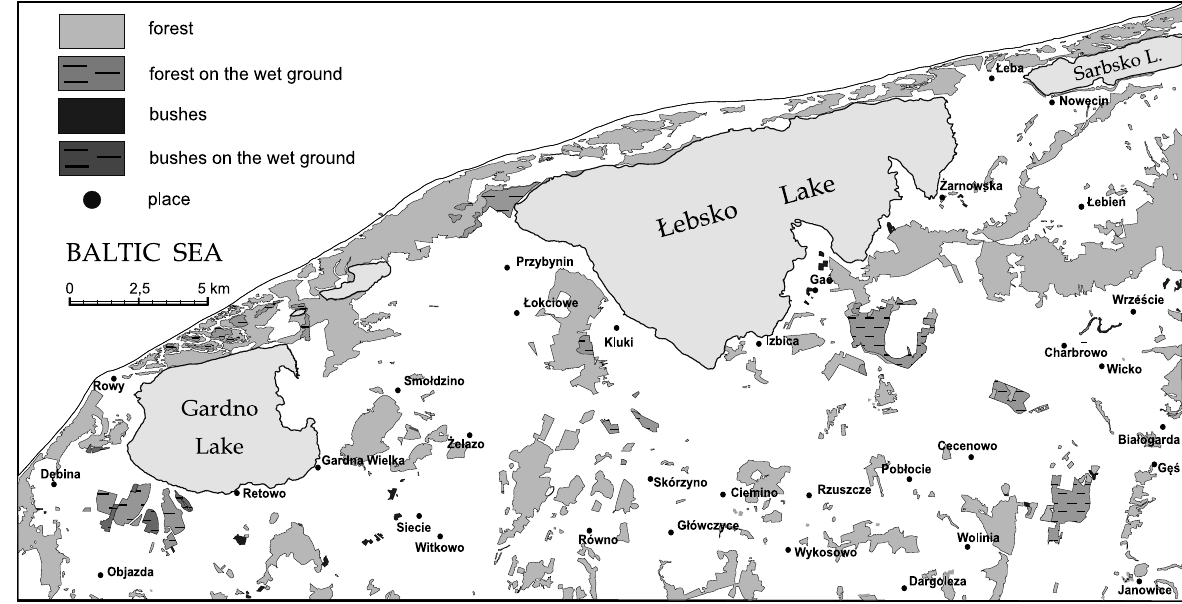
Fig. 9. Extent of forests in Gardno-Łeba Lowland in the early 20th